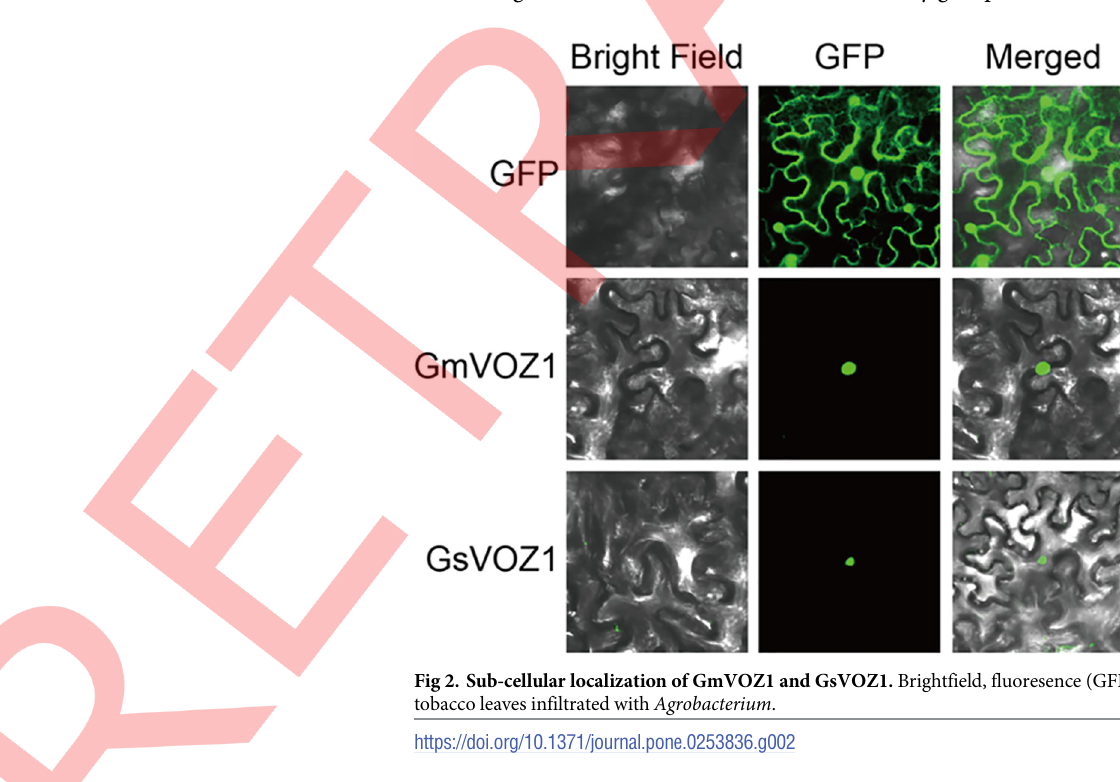
Fig 2. Sub-cellular localization of GmVOZ1 and GsVOZ1. Brightfield, fluoresence (GFP) and merged images of tobacco leaves infiltrated with Agrobacterium